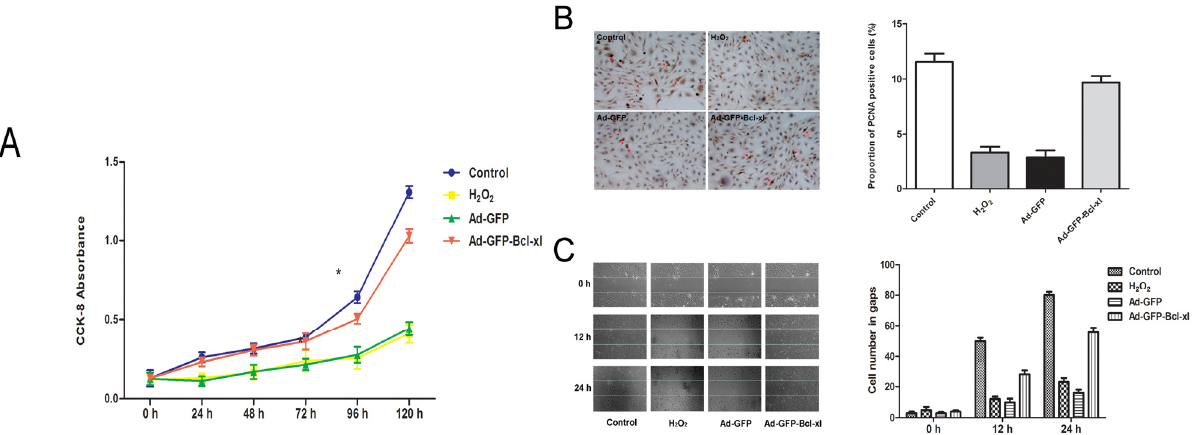
Figure 3. Evaluation of cell viability in each group. After being infected with Adv-GFP- Bcl-xl (or Adv-GFP) of 100 MOI for 48 h, HUVECs were subsequently stimulated with 0.5 mM H O for 12 h. Cell proliferative function is performed by ( A ) The 2 2 CCK-8 assay and ( B ) Immunocytochemical stain of proliferating cell nuclear antigen (PCNA) in HUVECs (×40). The red arrow represents PCNA positive cells; ( C ) Evaluation of cell migration functions by the scratching test. After being pretreated as described in the Methods section, we scratched the cells by using a pipette tip. Representative pictures were taken at 0 h, 12 h and 24 h. The cell number was counted in the scratched gaps. Control: O : HUVECs exposed with 0.5 mM H O ; Adv-GFP: HUVECs normal HUVECs; H 2 2 2 2 pretreated with empty virus and then exposed with 0.5 mM H O ; Adv-GFP- Bcl-xl : 2 2 O . Results HUVECs pretreated with Adv-GFP- Bcl-xl and then exposed with 0.5 mM H 2 2 are expressed as the means ± SEM ( n = 6). Statistical analysis was performed using one-way analysis of variance (ANOVA) followed by Tukey’s multiple comparison test ( * p <